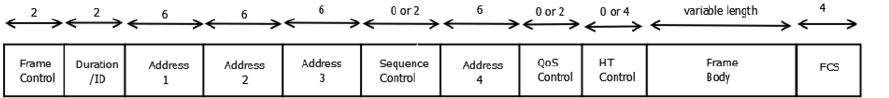
Figure 1. A standard 802.11 frame. Figure obtained from https://en.wikipedia.org/wiki/802.11 _Frame_Types, accessed on 20 April